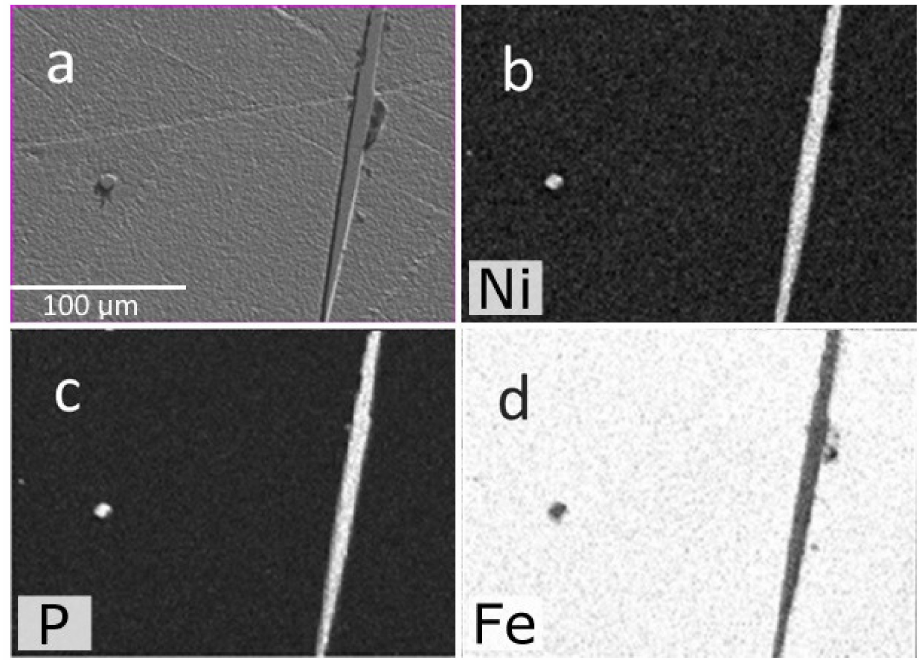
Figure 9. Micrograph ( a ) and elemental mapping obtained by microprobe analysis for Ni ( b ), P ( c ) and Fe ( d ) for the Campo del Cielo meteorite [31]. Table 1. Elemental composition of the meteorites determined by microprobe analysis [31]. Meteorite Mineral Fe (wt.%) Ni (wt.%) P (wt.%) Other Kamacite (matrix) Find 1 Campo del